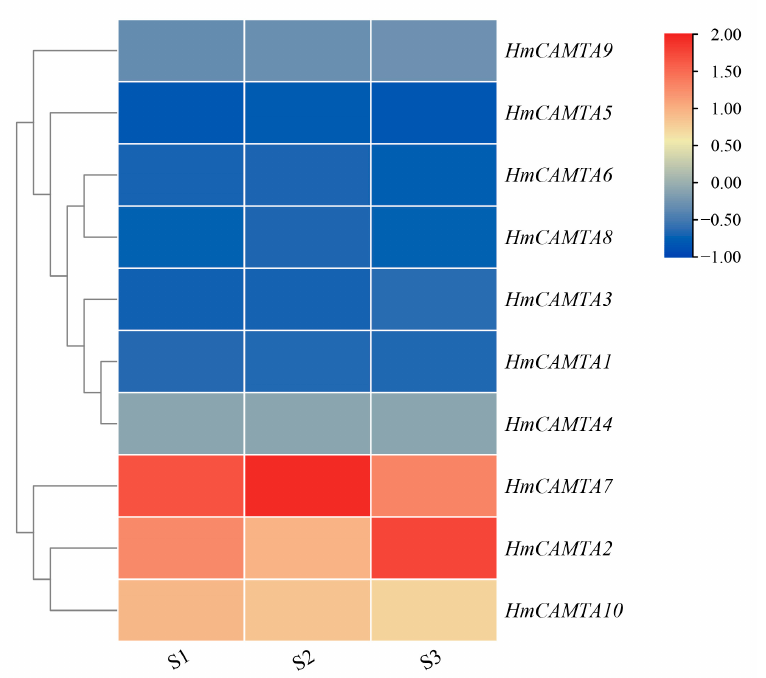
Figure 7. Heatmap expression of HmCAMTA genes under drought stress in transcriptome data (S1): Soil water content ranged from 65% to 75%; (S2): Soil water content ranged from 30% to 45%; (S3): Soil water content ranged from 5% to 15%. After homogenization, the value of expression appears in the heatmap, with red representing high expression and blue representing low expression.